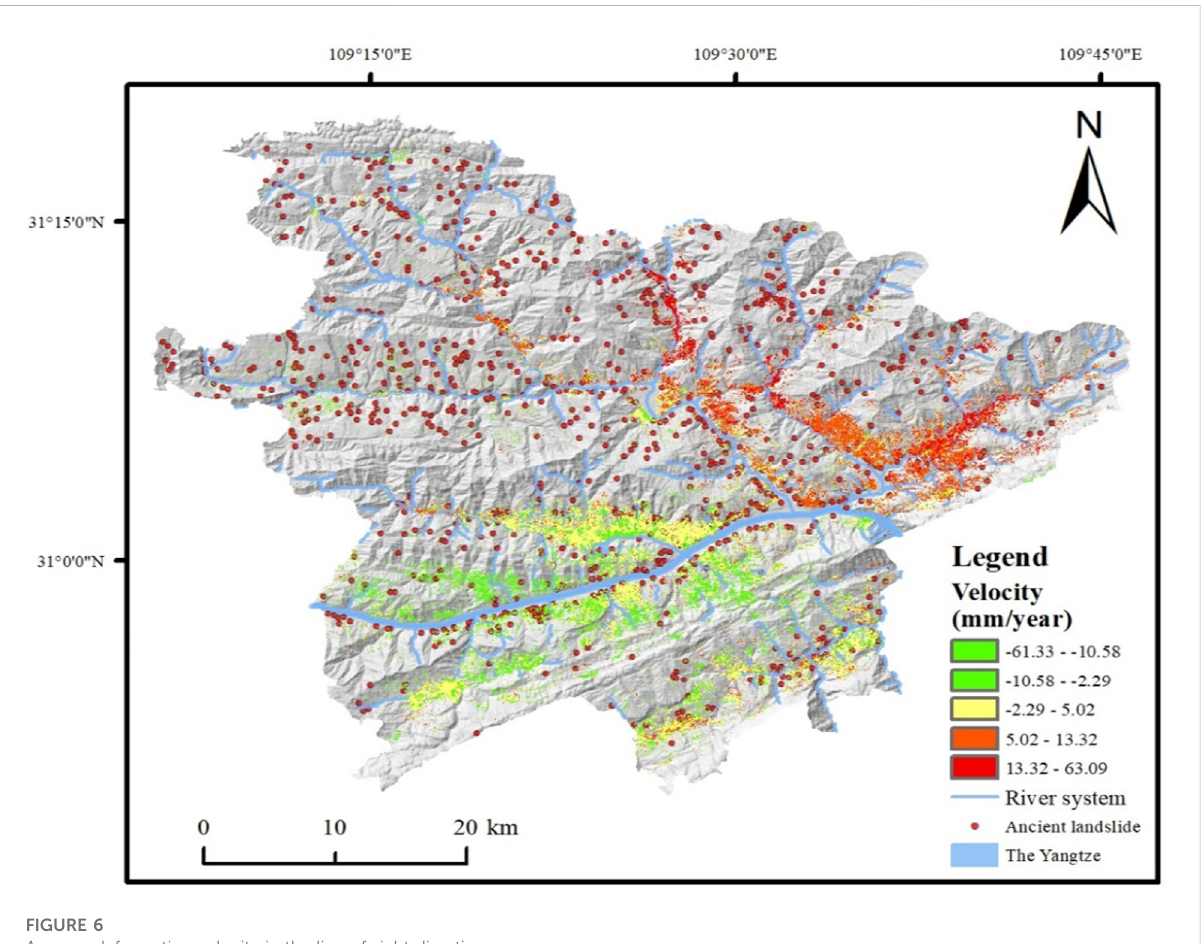
FIGURE 6 Average deformation velocity in the line of sight